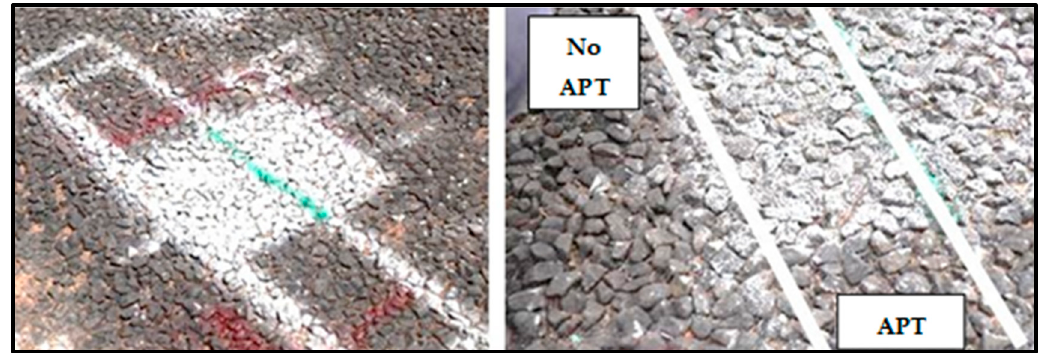
Figure 8. Condition of the 20 mm single chip seal in and outside the APT area. A 3D scan of the surfacing with and without loading: The height maps of the 20 mm seal produced from the 3D scans are shown in Figure 9 (APT loading on the left and no loading on the right). The blue-to-red 3D-generated pictures show the relative differences in height within the scanned areas. The less red in the scan after APT loading is an indication of the reorientation of the stone that has taken place and the filling of the vacant blue areas. The statistical evaluations of the data of the two scanned areas are given in Table